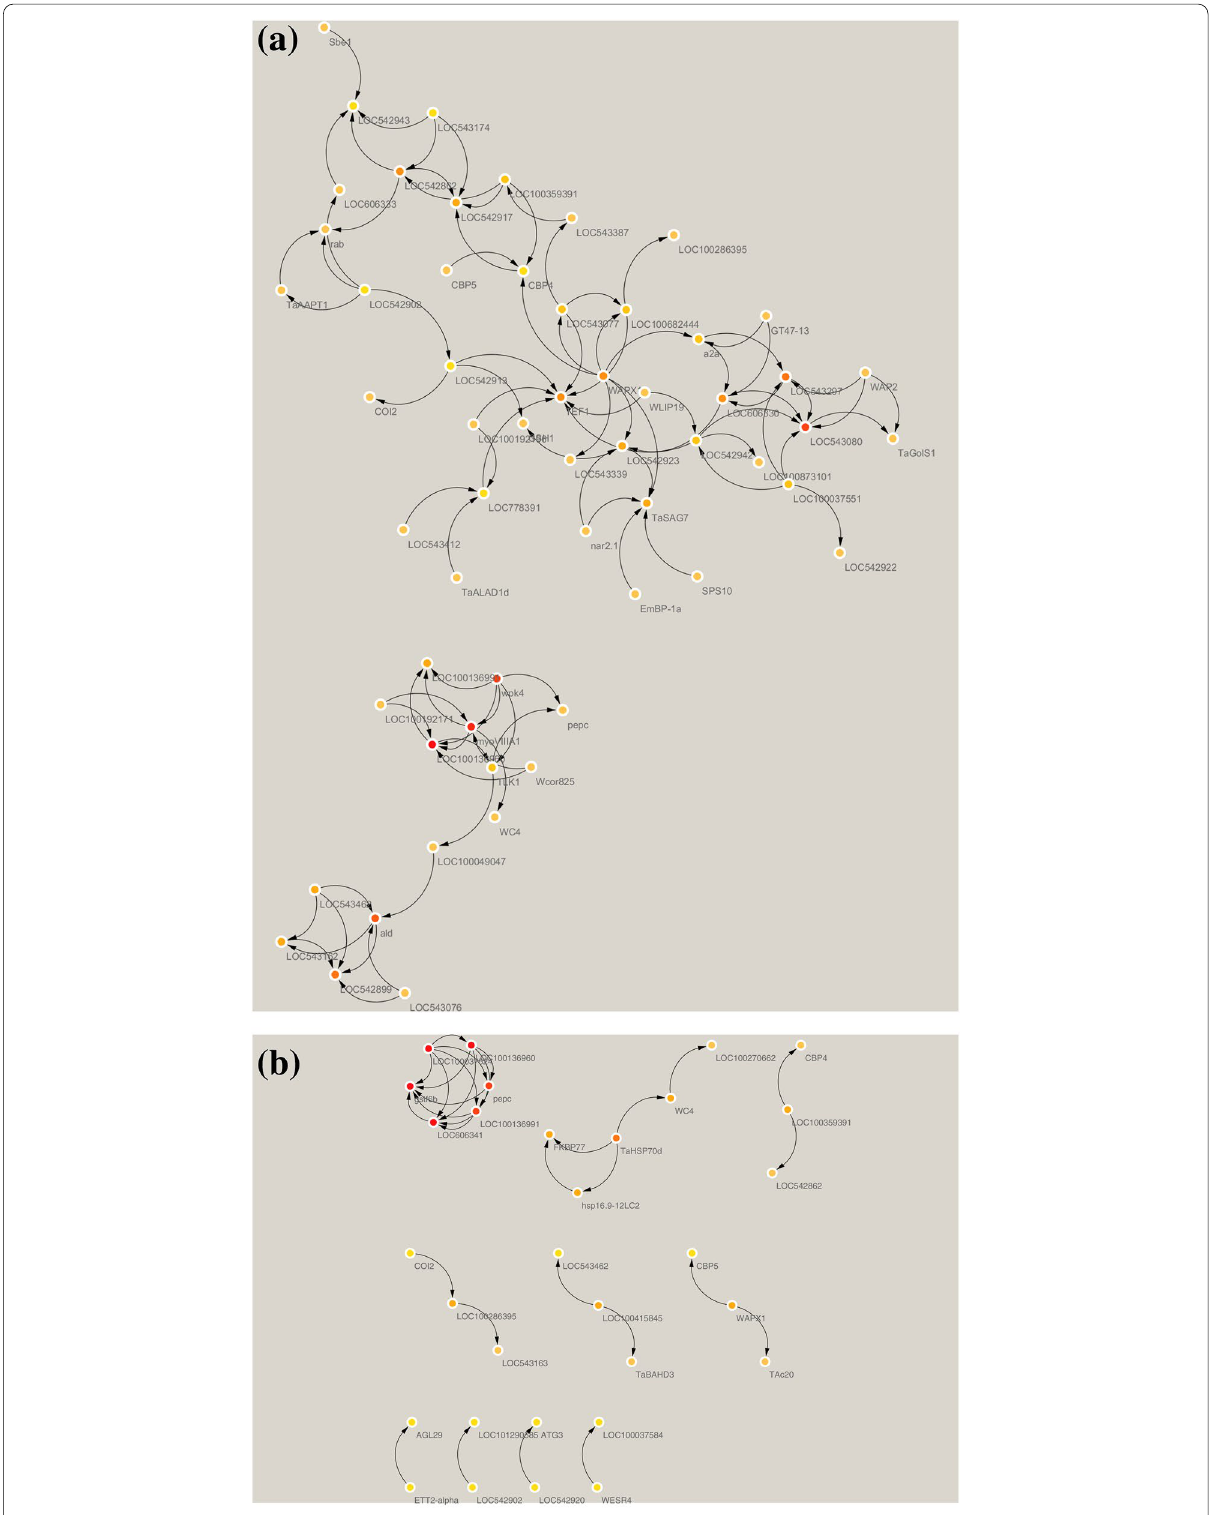
Fig. 5 Cytoscope diagram based on the symbols gene. A Resistant cultivars. B Sensitive cultivars The ranking is based on the MCC method in cytoHubba. Red to yellow, respectively, indicates a higher to lower